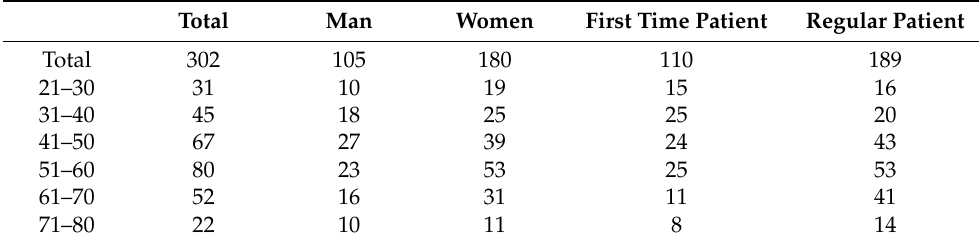
Table 2. Sample characteristics: number of patients in the respective groups. As some questionnaires variables were incomplete, the total numbers for some of the collected in the questionnaire data differs.